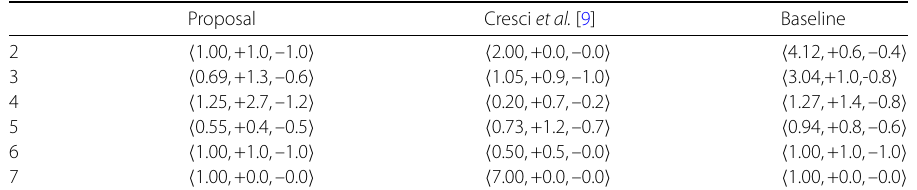
Table 10 Testing averaged MAE of the maximum Mercalli intensity for each earthquake Proposal Cresci etal. [9] Baseline